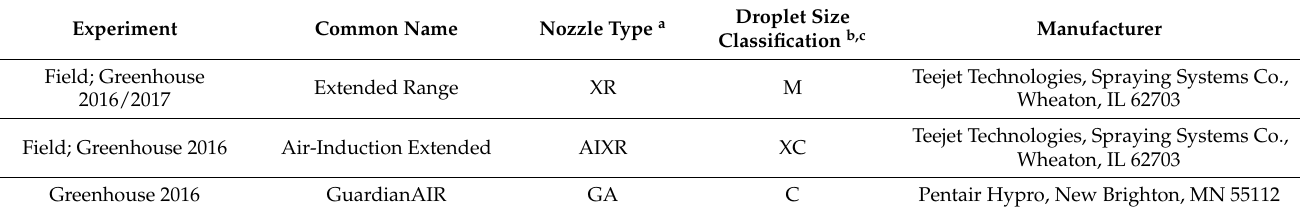
Table 2. Nozzle selection used in the field and/or greenhouse experiments as classified by their manufacturer and the spray droplet classification category in accordance with ASABE S572.1.